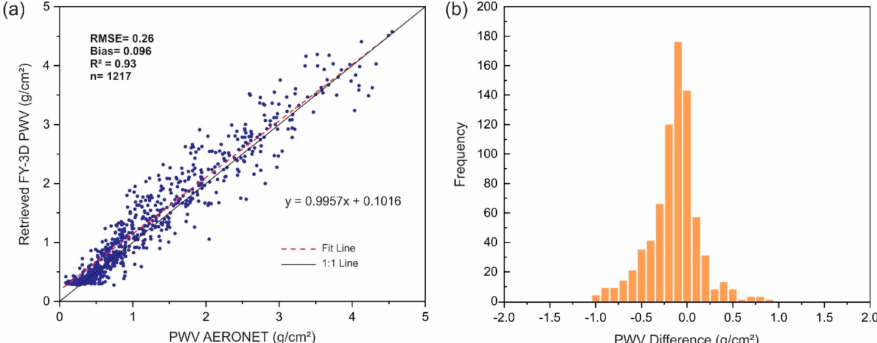
Figure 7. The scatterplot ( a ) depicts the retrieved PWV values from the proposed algorithm versus ground-based sun-photometer measurements where the black line is the ratio of 1:1 line; the red dotted line is the line fitted based on all the matched points and ( b ) the frequency distribution of the di ff erence between the retrieved PWV and ground-based